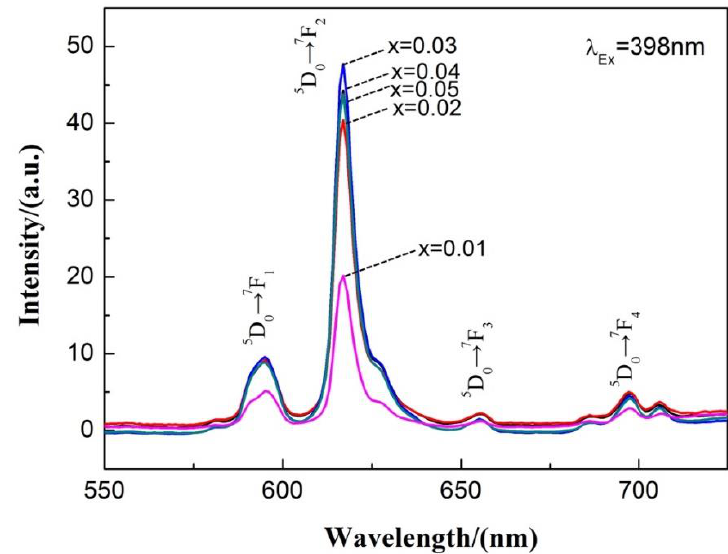
Figure 7. Emission spectra under an excitation wavelength of 398 nm of the Ca 1-x TiO 3 :Eu 3 + x phosphors doped with various concentrations of Eu 3 + synthesized by the traditional sintering processes.